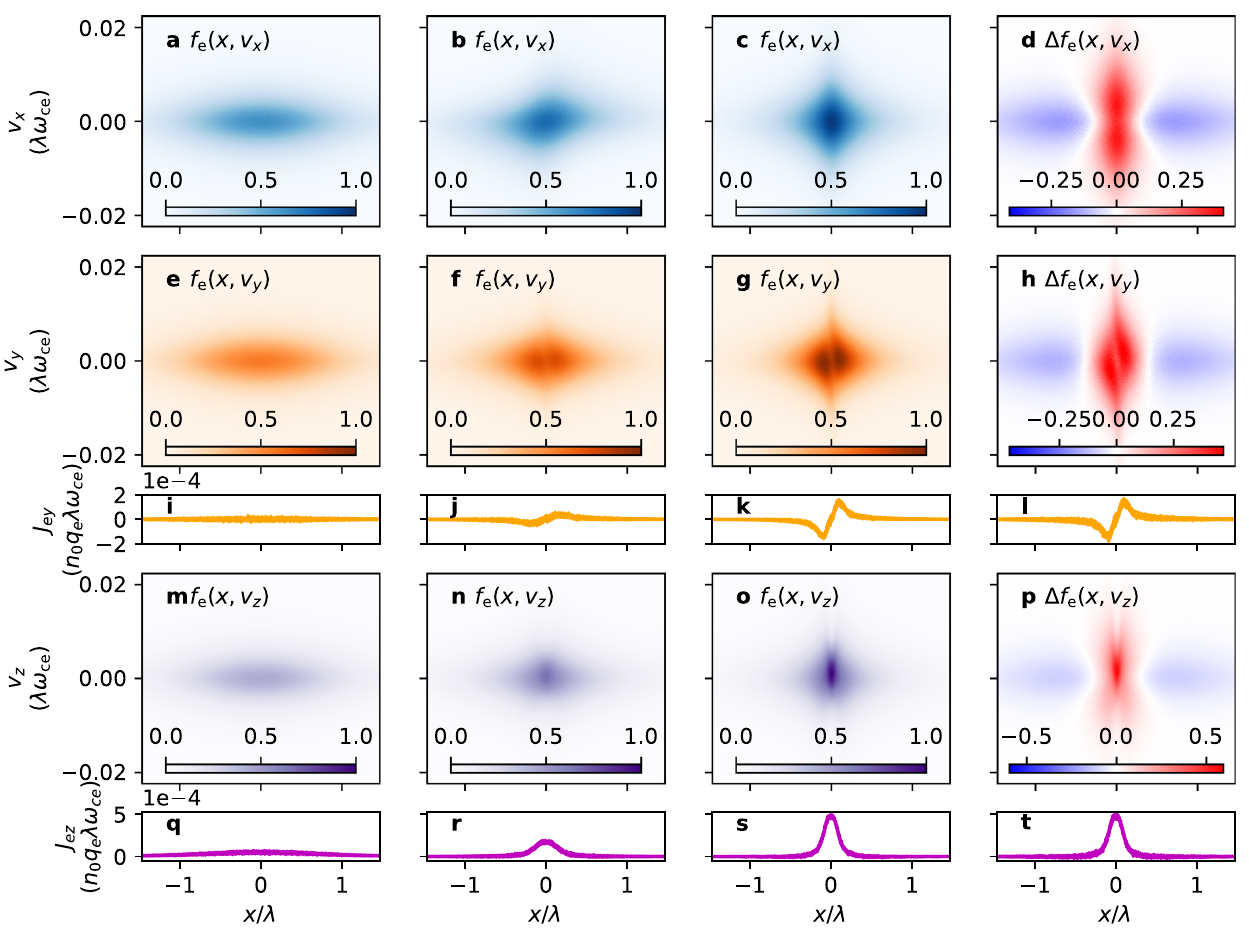
Fig. 6 | Time evolution of f e from the particle-in-cell simulation. Same as Fig. 5, but for